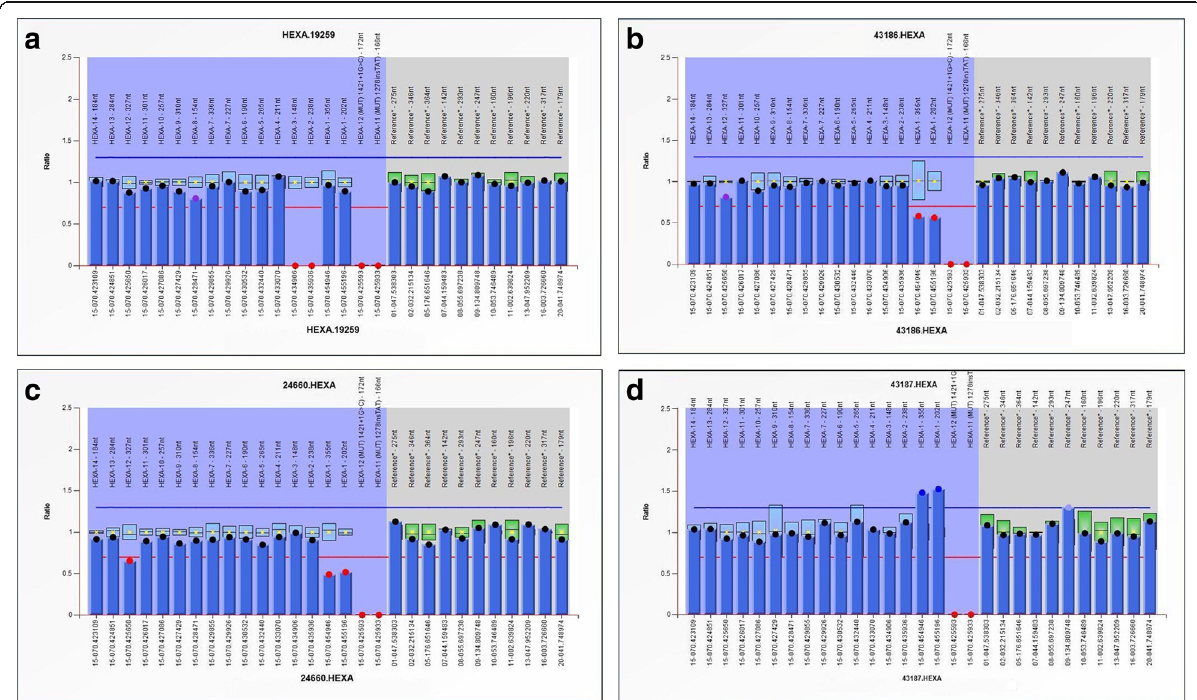
Fig. 1 MLPA analysis of HEXA gene ( a ): homozygous deletion of exon 2 & 3; ( b ) & ( c ): heterozygous deletion of exon 1; ( d ): heterozygous duplication of exon